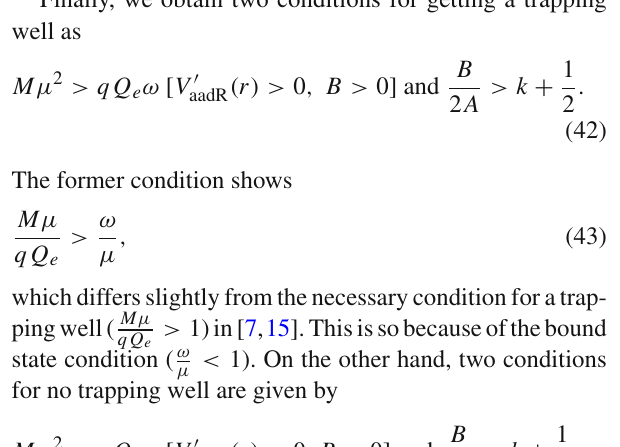
with λ = τ/μ the proper time per unit mass. The radial equatorial ( θ = π/ 2) motion for a charged particle takes the form (cid:10)